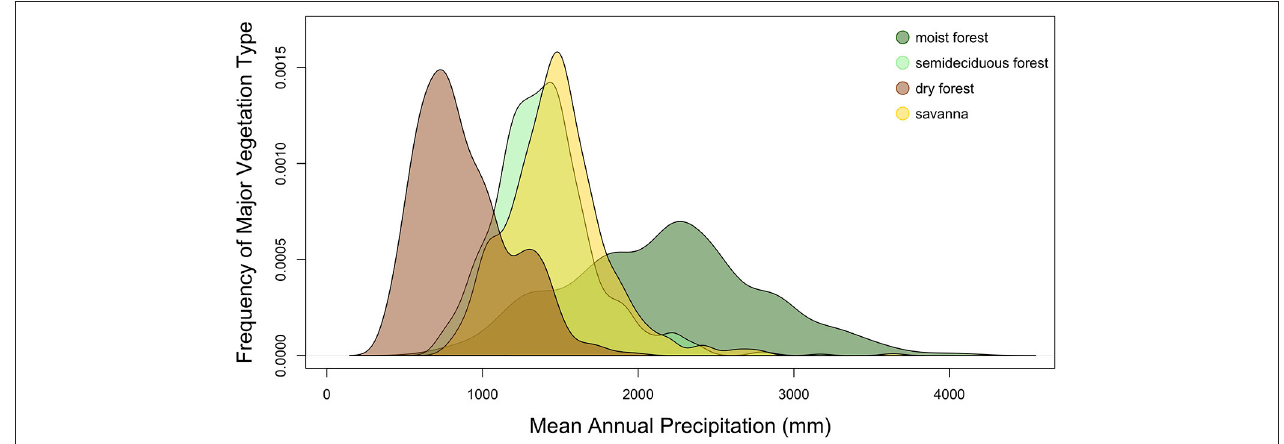
FIGURE 2 | Frequency distribution of sites in Figure 1 over a gradient in mean annual precipitation. For heuristic purposes, semideciduous and moist forests are distinguished although they may represent the same biome.